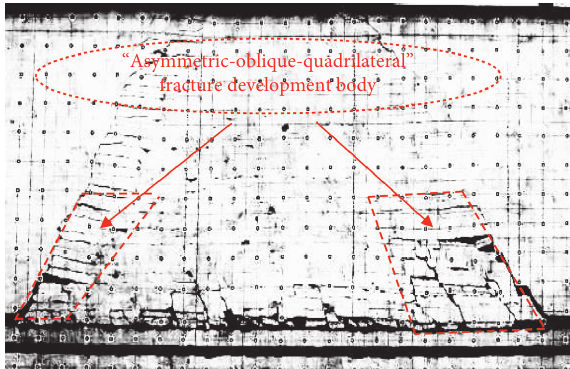
Figure 4: Grey processing analysis on distribution of fracture development in overlying